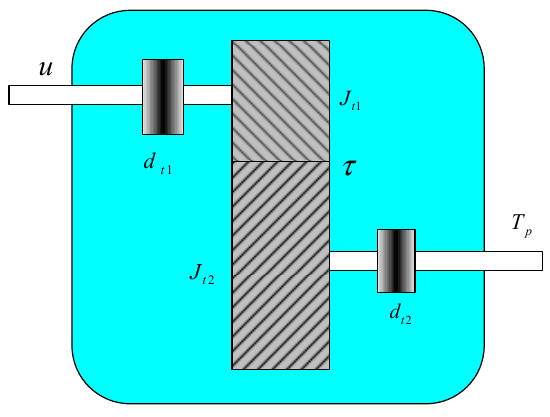
Figure 5. Simplified transmission model.